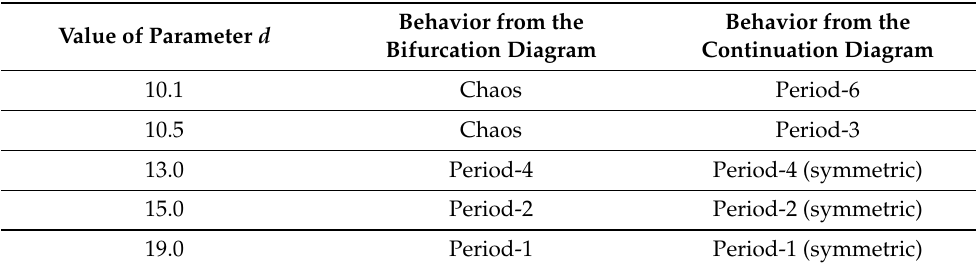
Table 1. Coexisting attractors as they are observed from the comparison of the bifurcation diagram with the respective continuation diagram of variable x versus the parameter d , for a = 4 × 10 − 4 , b = 1, c = 3.846 × 10 − 4 , e = 1.